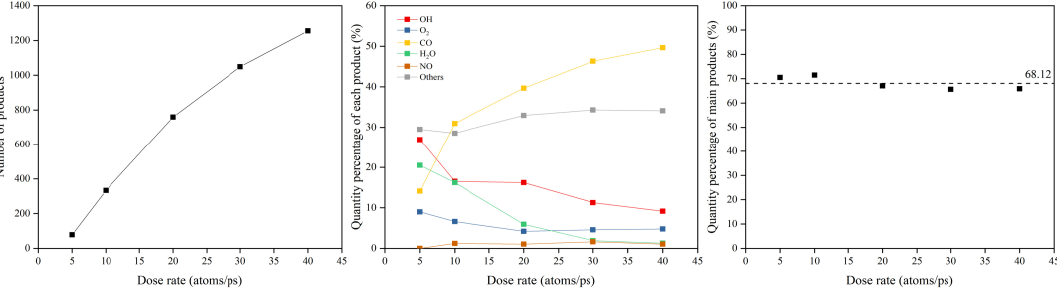
Figure 29. Product information of the Kapton after atomic oxygen impact at different dose rates.